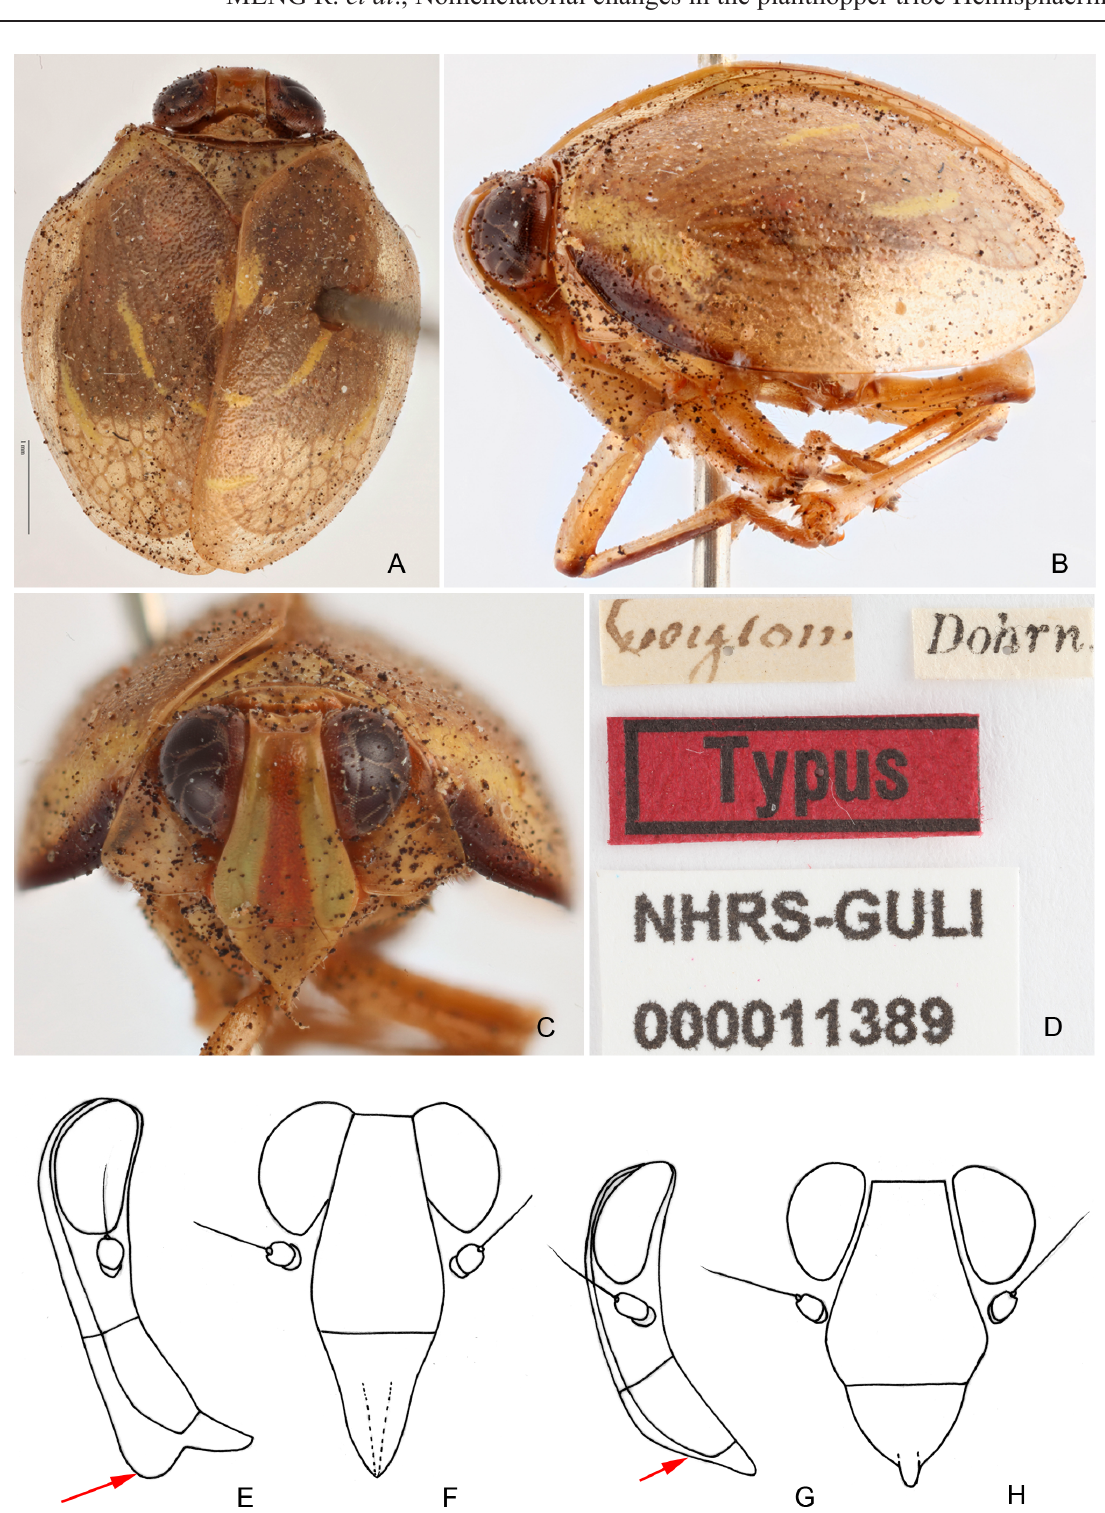
Fig. 7. Hemisphaerini. A–D . Gergithus schaumi (Stål, 1855), syntype. A . Habitus, dorsal view. B . Habitus, lateral view. C . Metope and clypeus, facial view. D . Label. — E–F . Gergithus frontilongus sp. nov. E . Metope and clypeus, lateral view. F . Metope and clypeus, facial view. — G–H . Gnezdilovius iguchii (Matsumura, 1916) comb. nov. G . Metope and clypeus, lateral view. H . Metope and clypeus, facial view. Arrows points the anteclypeus angular